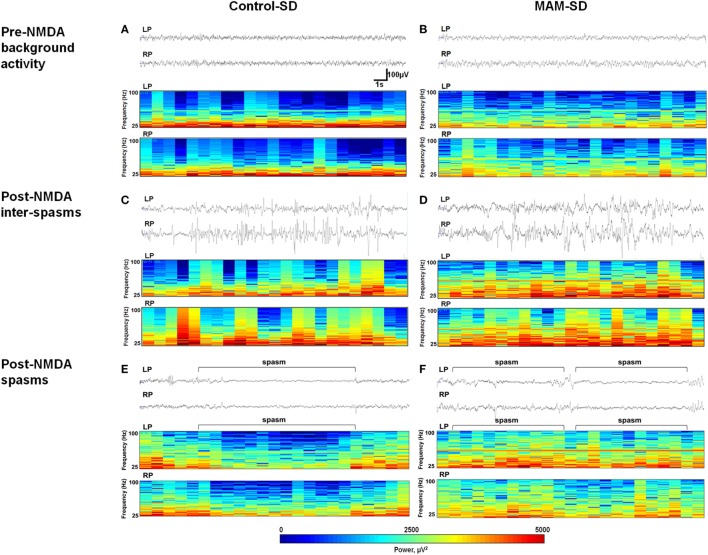
Electroencephalographic (EEG) recordings and color density spectral arrays (CDSAs) of N-methyl-d-aspartate (NMDA)-induced spasms and inter-spasm periods. Monopolar EEG recordings were performed from two intracranial electrodes on the left parietal (LP) and right parietal (RP) areas. Upper panels present 30-s EEG samples from methylazoxymethanol acetate (MAM) and control group animals and the lower panels the corresponding CDSAs for same period bandpass filtered at 0.5–100 Hz. The CDSAs display a color-coded, three-dimensional contour plot with time on the horizontal axis, frequency (25–100 Hz) on the vertical axis and color scale power (μV2) [see scale below lower panel of (E,F)]. (C,D) Both prenatally MAM and control rats administered a single NMDA dose (SD) showed frequent spikes intermixed with high-amplitude slow wave activity. The corresponding CDSAs demonstrate more prominent fast oscillations (25–100 Hz) during post-NMDA inter-spasms periods than during pre-NMDA resting background activity (A,B). (E,F) Sample EEGs during post-NMDA spasms indicate low-amplitude fast activities superimposed on the attenuated background in both control-SD and the MAM-SD groups. In the corresponding CDSAs, more prominent FOs were revealed in the MAM-SD group compared to the control-SD group.